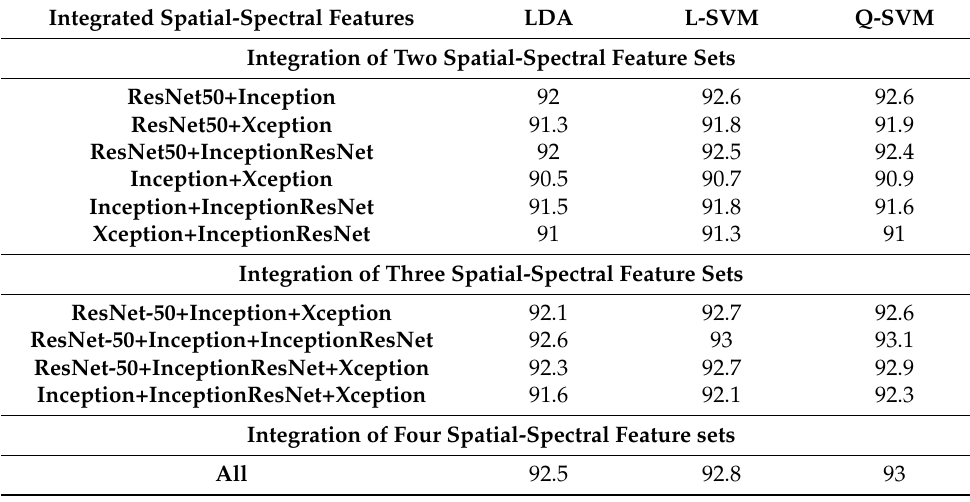
Table 3. The accuracy (%) attained for the three classifiers trained with integrated spatial-spectral features using AE.